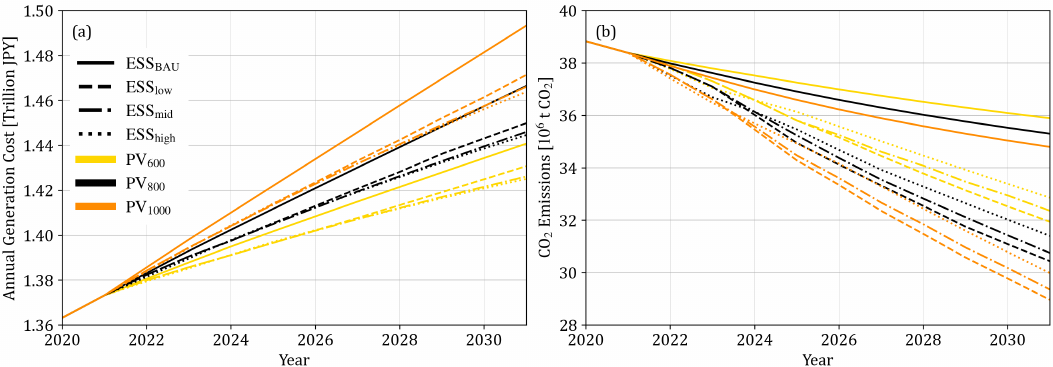
Figure 16. ( a ) Total annual cost and ( b ) CO 2 emissions of the electricity generation for the whole Kyushu grid of business as usual (BAU; no change in ESS capacity) and the optimal ESS